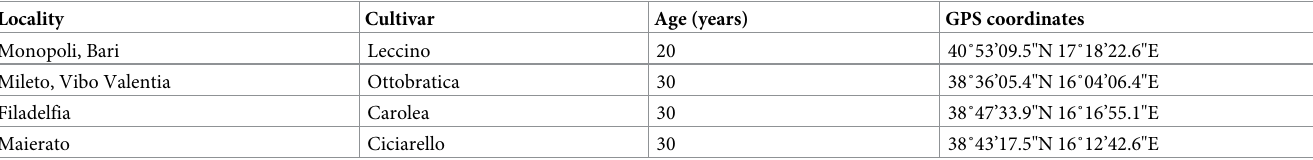
Table 1. Source of infested and non-infested olive samples analyzed in the present study.